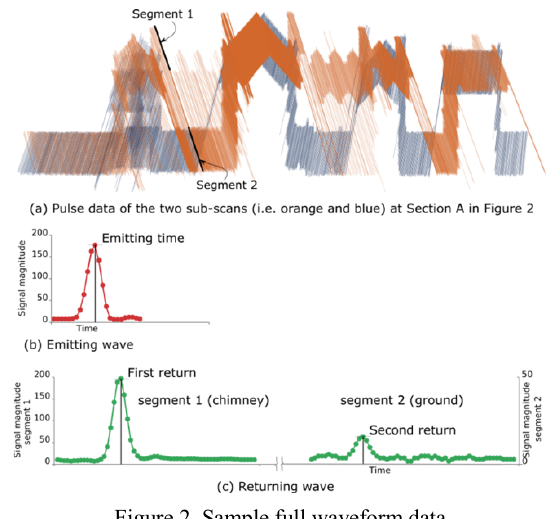
Figure 2. Sample full waveform